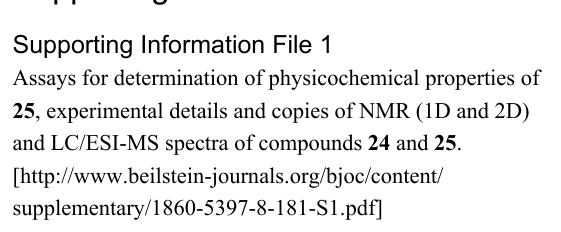
as a representative of this new class of heterocyclic